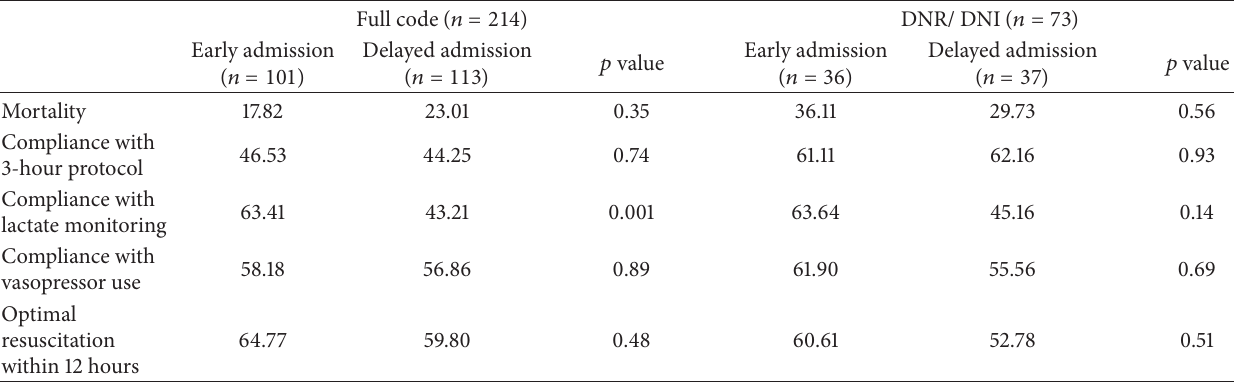
Table 4: Compliance with sepsis bundles and optimal resuscitation within 12 hours comparing code status (full code versus